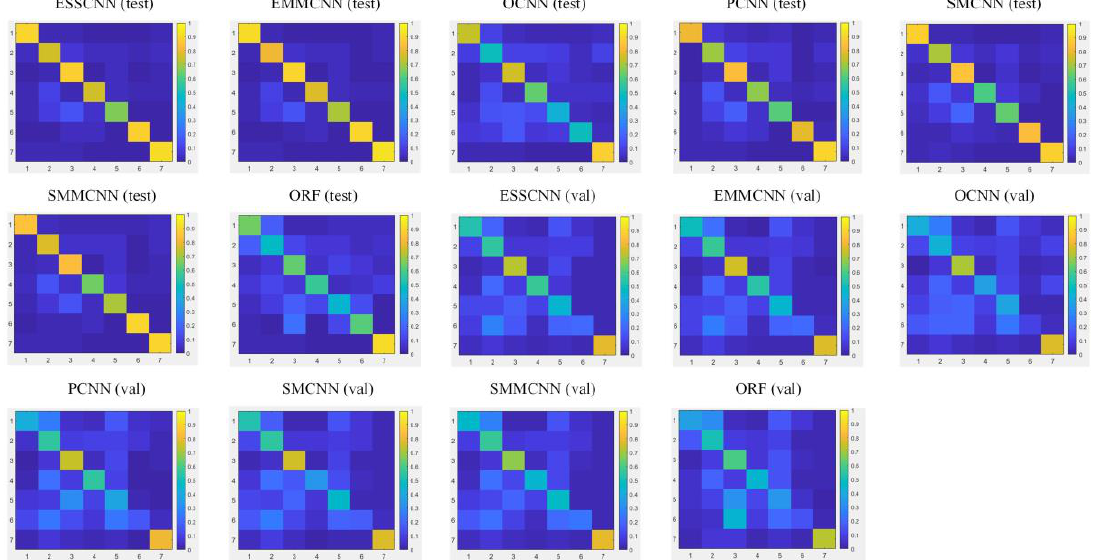
Figure 13. Confusion matrices of testing (test) and validating (val) samples in the Yuecheng dataset for the ESSCNN, EMMCNN, OCNN, PCNN, SMCNN, SMMCNN, and ORF methods. The numbers 1 to 7 in horizontal and vertical axis denote the farmland, woodland, building, road, impervious surface, vacant, and water classes, respectively. ESSCNN: extended topology-preserving segmentation